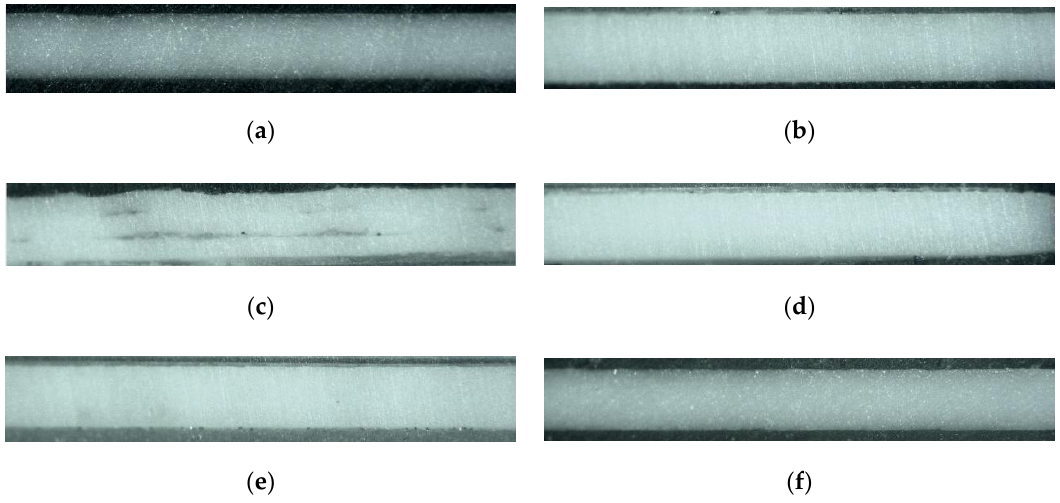
Figure 7. Cross-sections of the samples, after firing: ( a ) HEC 2 wt%, ( b ) HEC 5 wt%, ( c ) agar-agar, ( d ) gelatin, ( e ) carbon paste, and ( f ) no SVM. For all samples, except the agar-agar sample, lamination between layers is excellent.